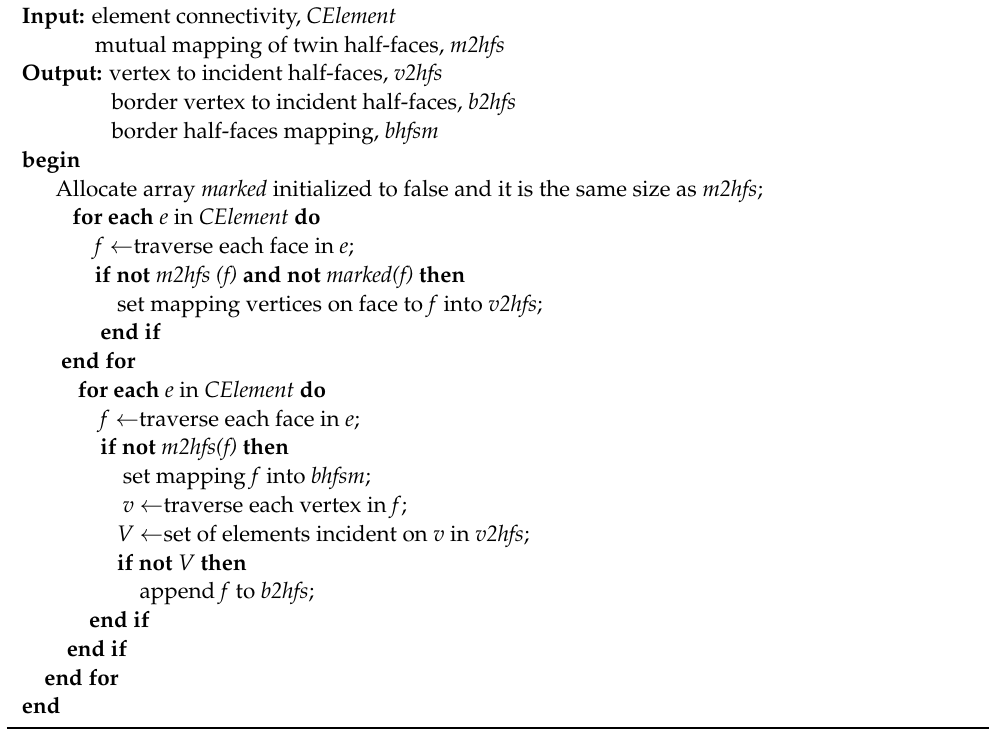
Algorithm 2: Construction of topological